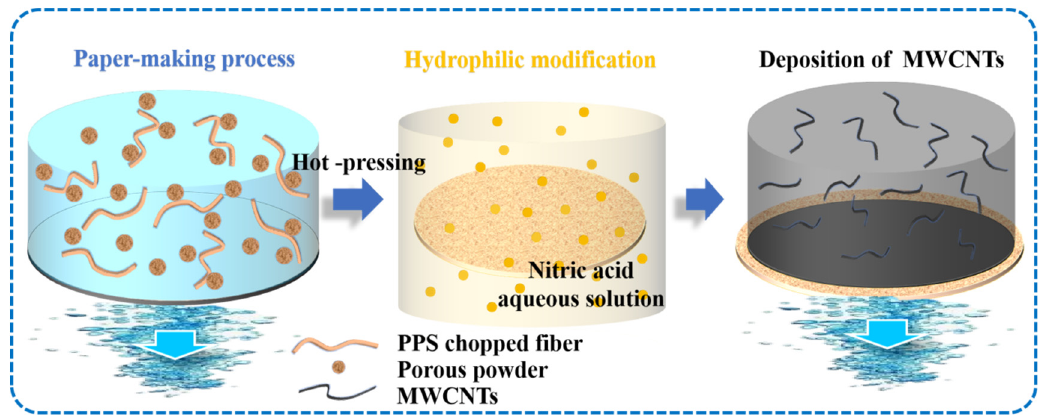
Figure 1. Illustration of the preparation of the MWCNTs@HPPS paper.